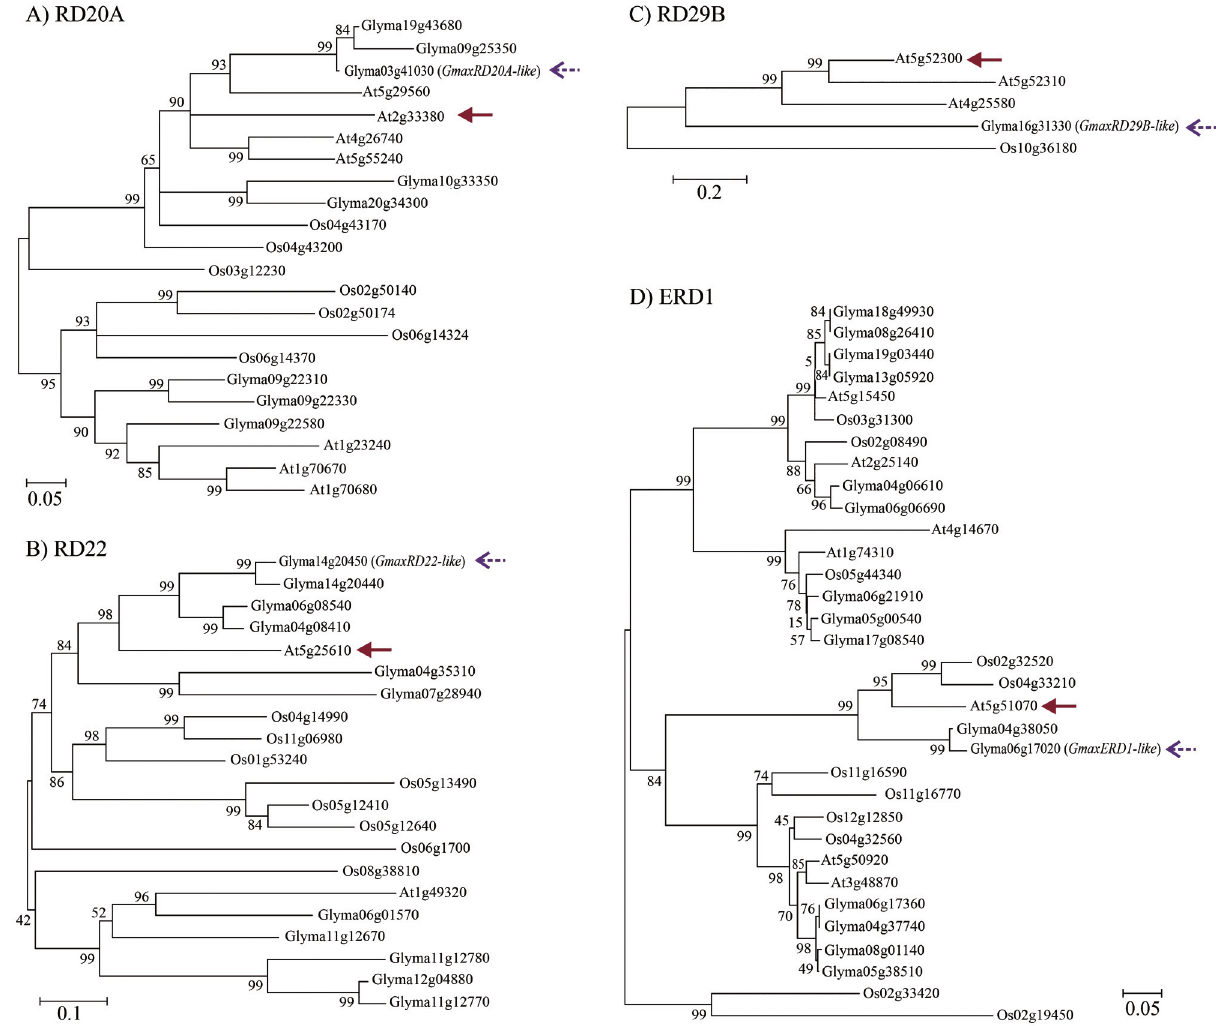
Figure 1 - Dendrograms of the Arabidopsis thaliana , Glycine max and Oryza sativa key genes responsive to drought, based on the amino acid sequences. The multiple alignment was made using ClustalW2 and the dendrograms were built using MEGA4.0 software, with the Neighbor-Joining and pair-wise deletion options as a consensus of 1,000 bootstrap replicates. O. sativa was used as outgroup. The solid brown arrows indicate the Arabidopsis reference key genes and the dotted purple arrows indicate the respective soybean homologs selected for qPCR validation of expression. A) Dendrogram of the RD20A family of A. thaliana , G. max and O. sativa ; B) Dendrogram of the RD22 family of A. thaliana , G. max and O. sativa ; C) Dendrogram of the RD29B family of A. thaliana , G. max and O. sativa ; D) Dendrogram of the ERD1 family of A. thaliana , G. max and O. sativa